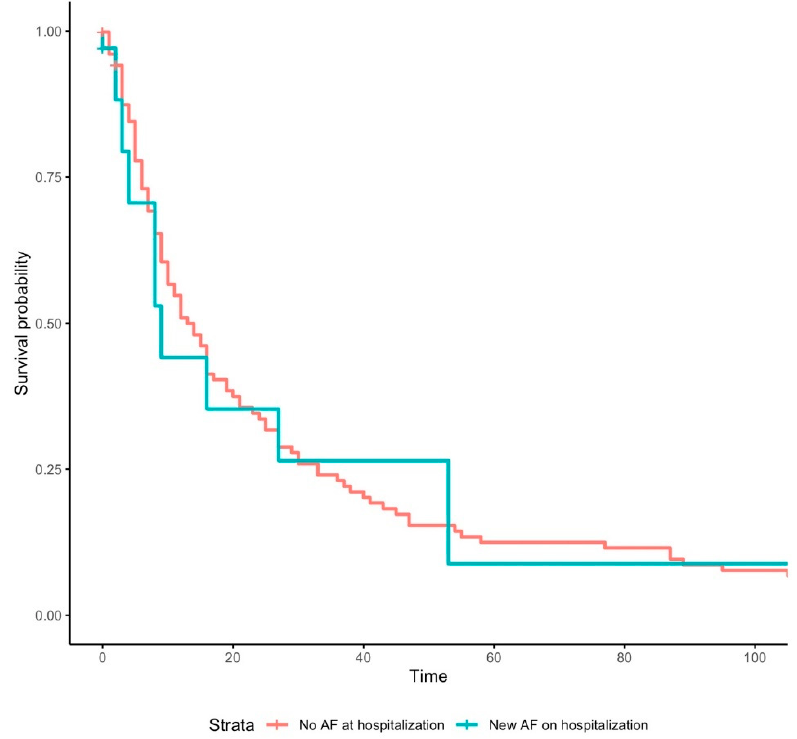
Figure 6. Kaplan–Meier survival curve for “Long-Term Mortality” in patients with COVID-19 with no atrial fibrillation and newly diagnosed atrial fibrillation. Abbreviations: AF = atrial fibrillation. Predictive factors for in-hospital mortality were age ≥ 79 years (OR: 9.53; p < 0.01) and immunosuppressive therapy (OR: 4.3; p = 0.01). The risk for long-term